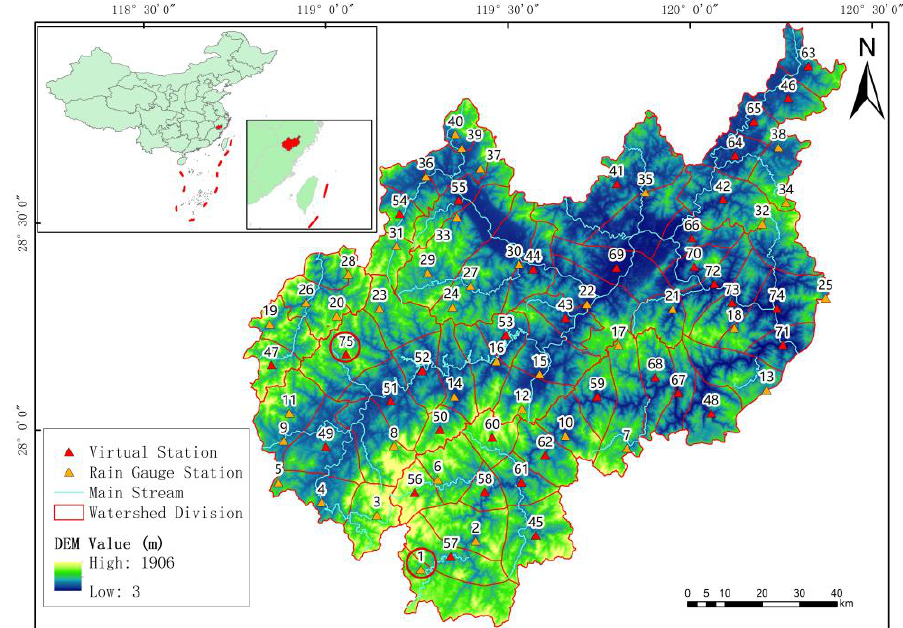
Figure 4. Oujiang River Basin and rain gauge station distribution.